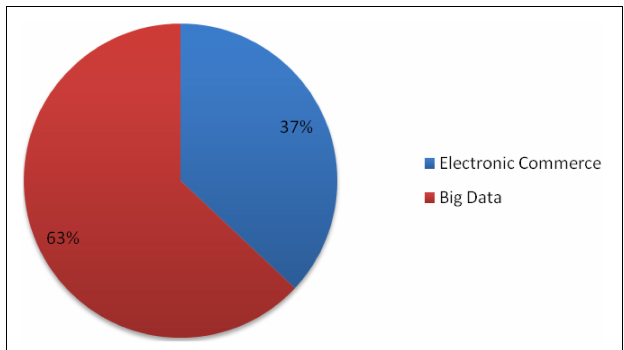
FIGURE 6 | Impact of big data and e-commerce on industrial agglomeration